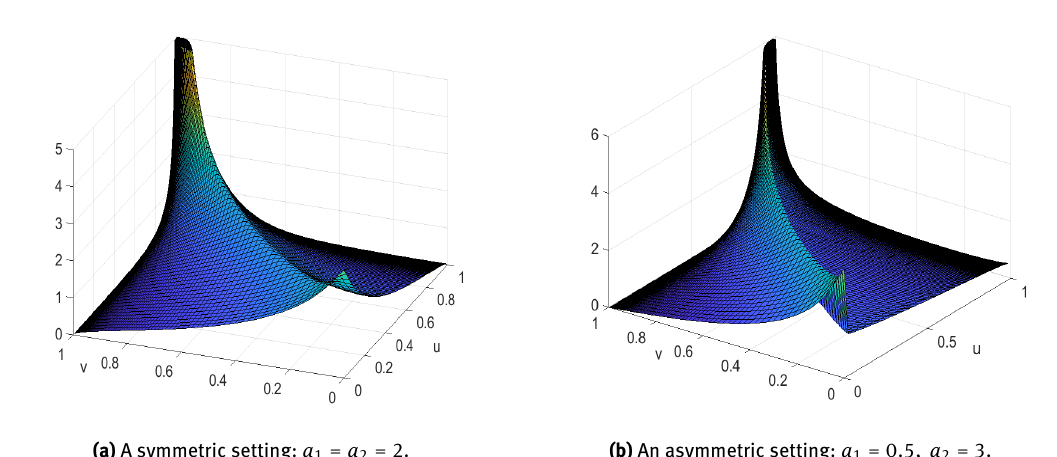
Figure 2: Copula density of ( X 1 , X 2 ) for two different parameter